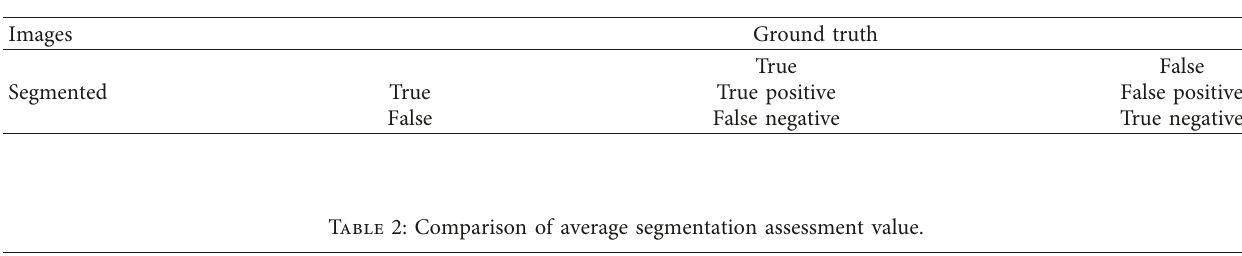
Figure 2: Diagram of the multiphase edge detection algorithm of image with activated sludge. Table 1: Confusion matrix.